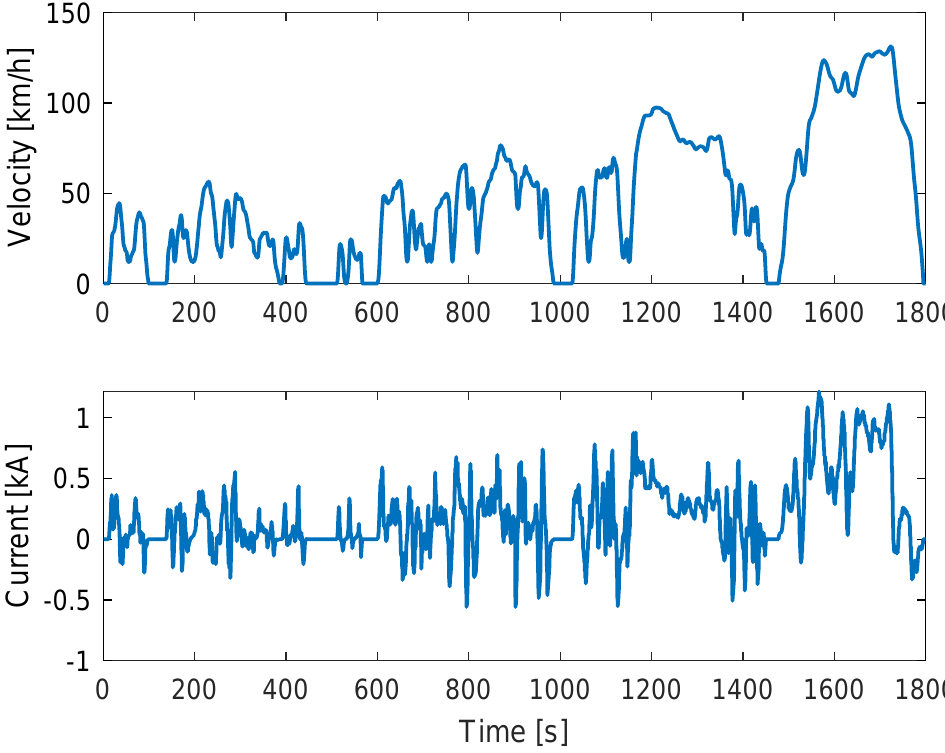
Figure 10. Velocity and calculated motor current over a World harmonized Light-duty vehicles Test Procedure (WLTP) drive cycle. Negative current corresponds to periods of regenerative